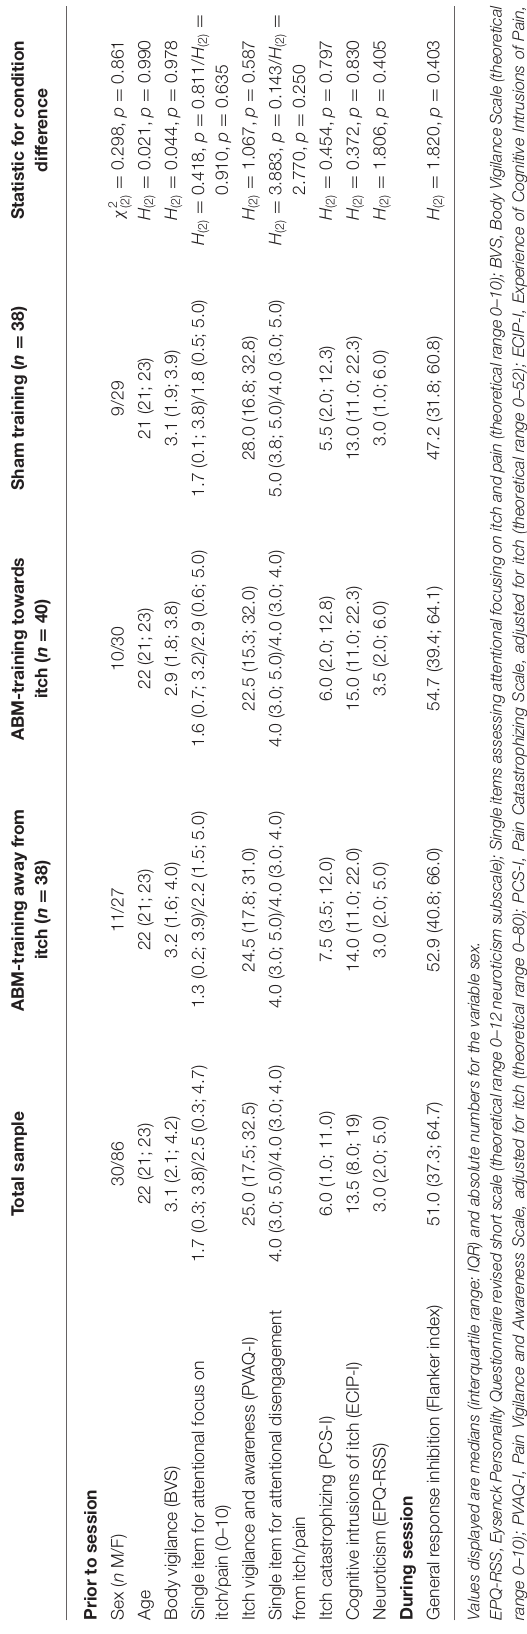
Mean (range) Median (IQR)